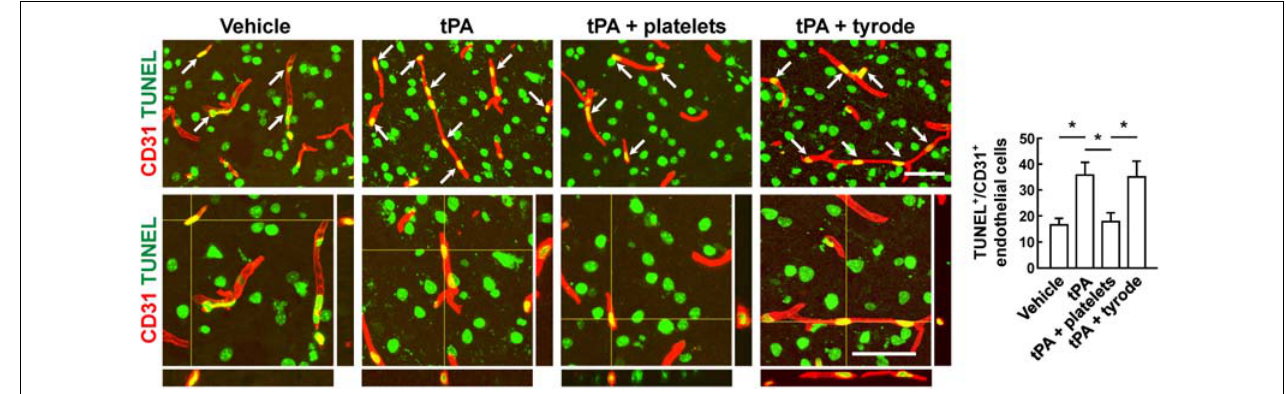
FIGURE 4 | Transfusion of resting platelets reduced tPA-induced loss of vascular endothelial cells after cerebral ischemia. Representative photomicrographs and quantification of TUNEL+/CD31+ endothelial cells in mice treated with vehicle, tPA, tPA + resting platelets, or tPA + tyrode buffer after cerebral ischemia. Bar = 60 µ m. n = 5 per group. Values are mean ± SD. ∗ P < 0.05.